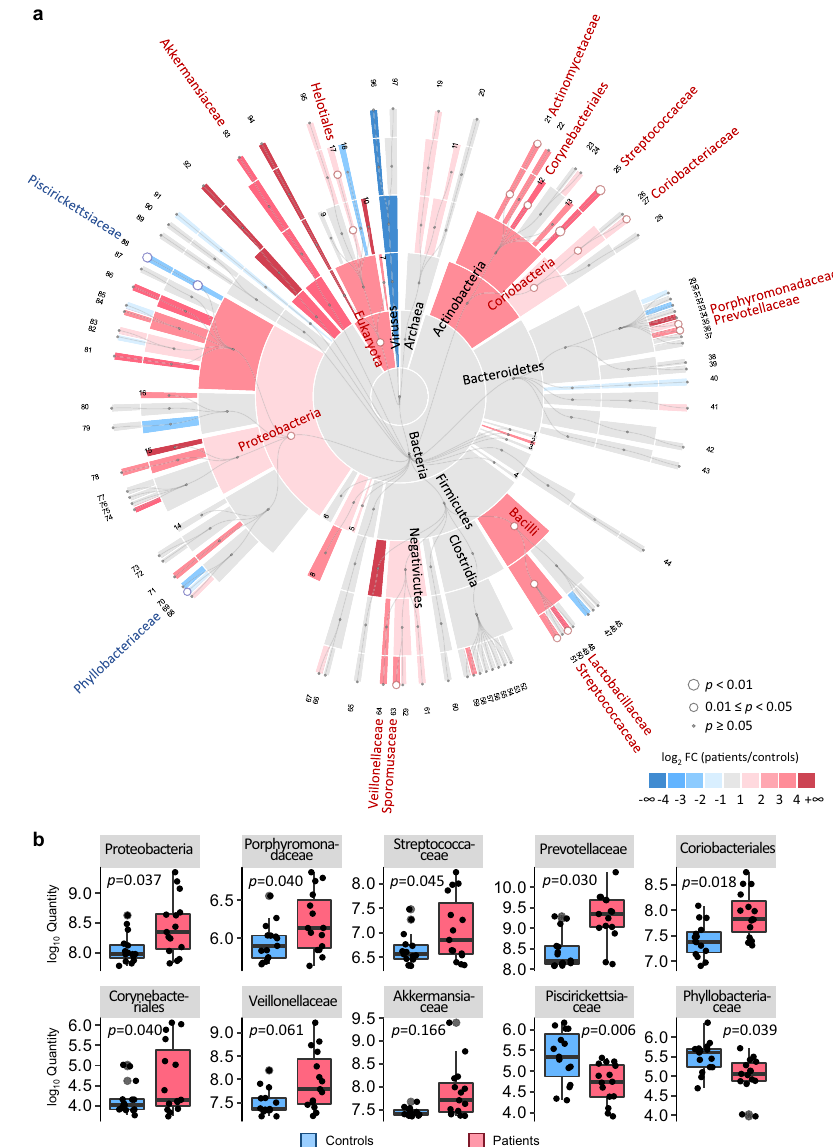
Fig. 5 Taxonomic abundances based on microbial proteins of the PC patients and controls. a Cladogram illustrating abundance of taxa (domain to family). Colors indicate the log2 fold change (FC, patients/controls) between the patients and controls; circle sizes indicate the p-value (t-test). Names of the taxa are highlighted in red (more abundant in the patients) or blue (more abundant in the controls) color if their signi fi cant abundance differences between patients and controls were observed in this work (p-value < 0.05) or have been reported in previous studies. Information of the taxa with the labeled numbers are shown in Supplementary Data 12. b Boxplots showing the abundance of the differential taxa between the patients and controls. The boxes mark the fi rst and third quantile and the lines inside the boxes mark the median; the whiskers extend from the ends of the inter-quartile range (IQR) to the furthest observations within the 1.5 times the IQR. Individual data points are overlaid as dots. The p -values are indicated. Source data are provided as a Source Data fi